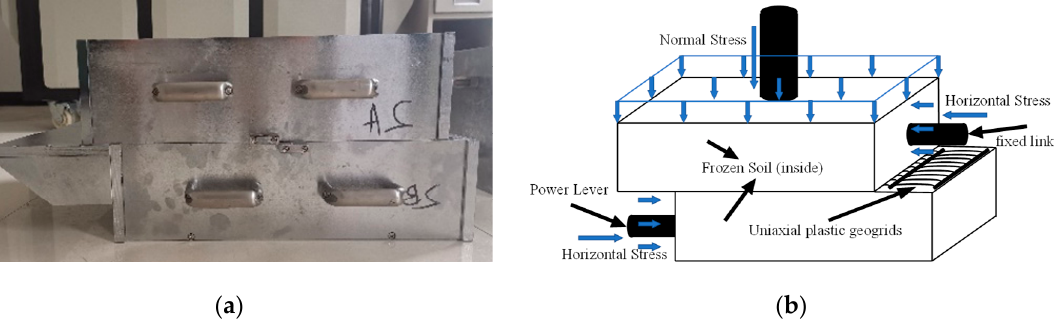
Figure 2. Soil box of the direct shear test and schematic diagram of the specimen stress. (a) Soil box; (b) schematic diagram of specimen stress. The normal bar at the top of the upper box applies a normal force downward and